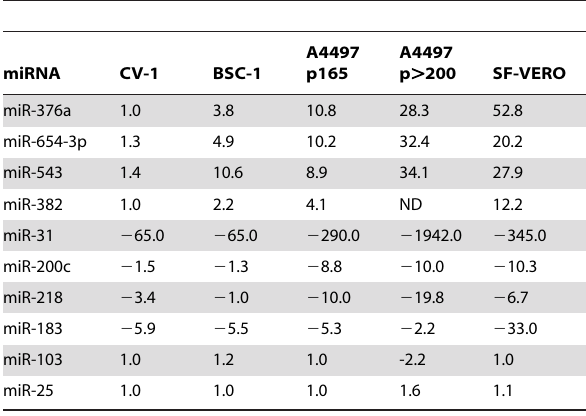
Table 4. The expression patterns of selected miRNA in other AGMK cells using Taqman quantitative RT-PCR 1 .